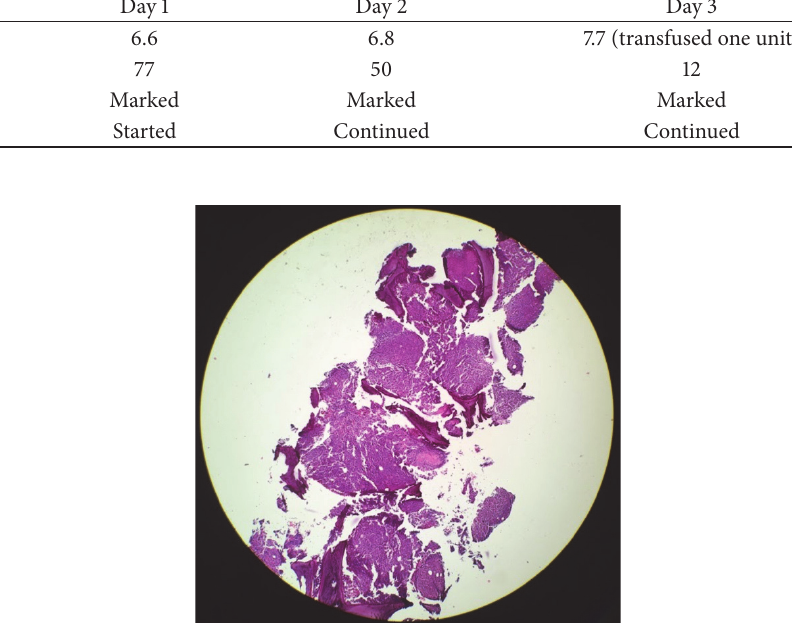
Figure 3: Bone Marrow Core Biopsy: low power magnification, highly cellular bone marrow.